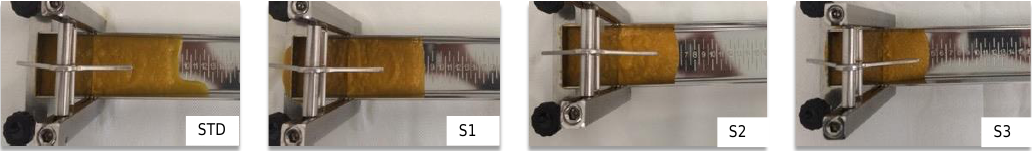
Figure 6. Appearance and Bostwick Running Distances of cooked commercial carrot soup ( STD ) and carrot soup samples at increasing M 2 level ( S1 – S3 ).